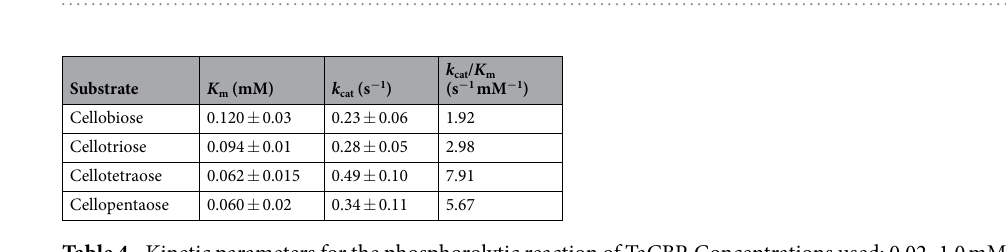
Table 4. Kinetic parameters for the phosphorolytic reaction of TaCBP. Concentrations used: 0.02–1.0